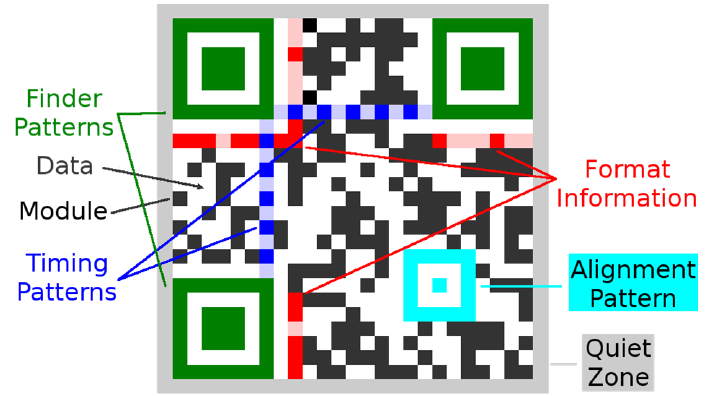
Figure 1. Version 2: 25 × 25 modules Quick Response (QR) Code.